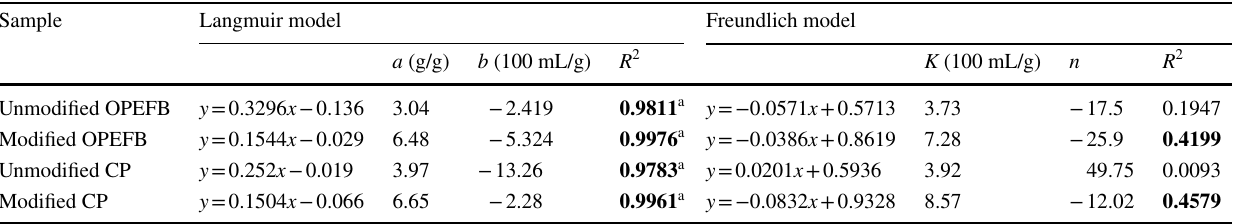
Table 1 The Langmuir and Freundlich isotherm data